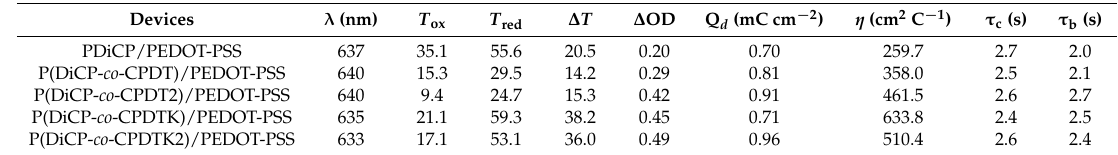
Table 6. Optical and electrochemical properties investigated at the selected applied wavelength for the devices.